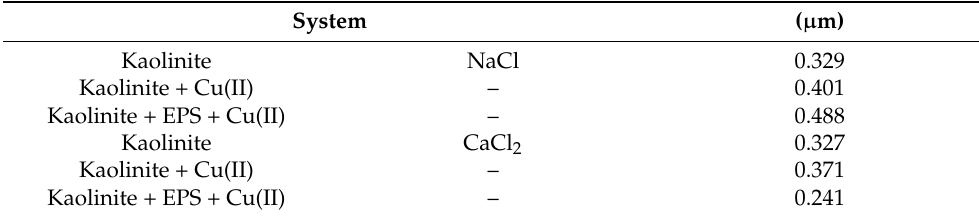
Table 2. Average diameter [ µ m] of particles/aggregates in kaolinite suspension prepared using two different supporting electrolytes; the CPS analyses were performed in the diameter range from 0.11 to 5 µ